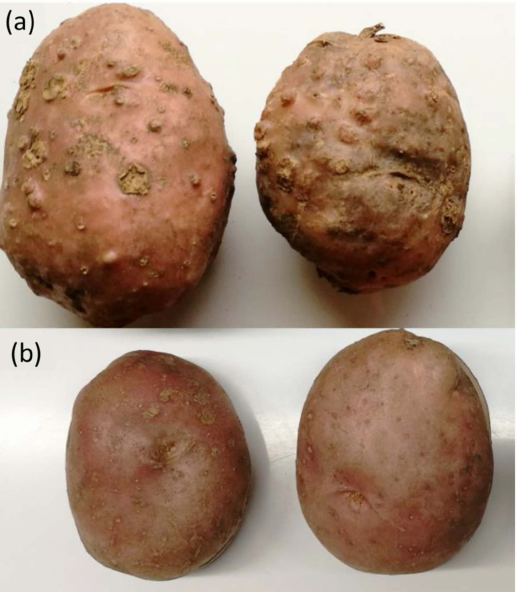
Figure 1. Inoculated and healthy potato tuber. ( a ) inoculated tubers, and ( b ) healthy tubers. Note the galls on the surface of the infested tubers. The difference in size is not necessarily